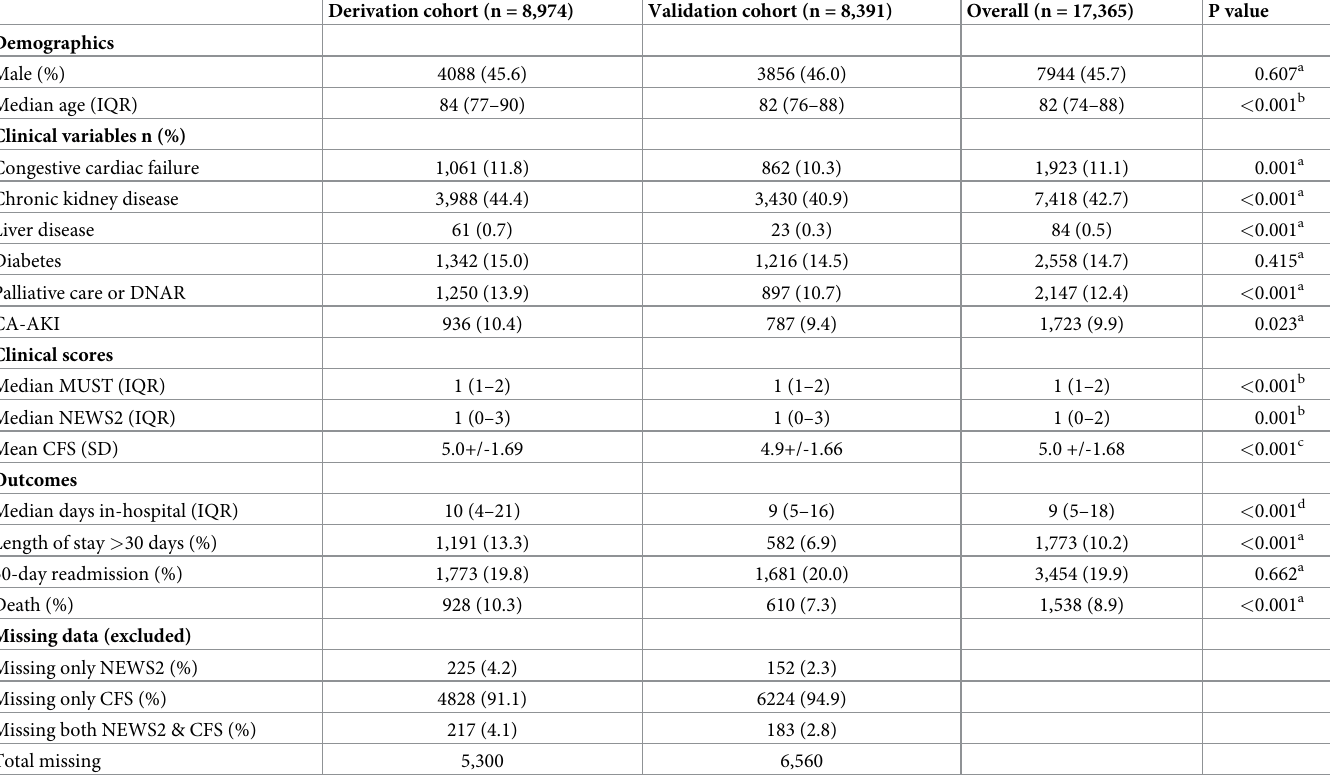
Table 1. Baseline characteristics for each